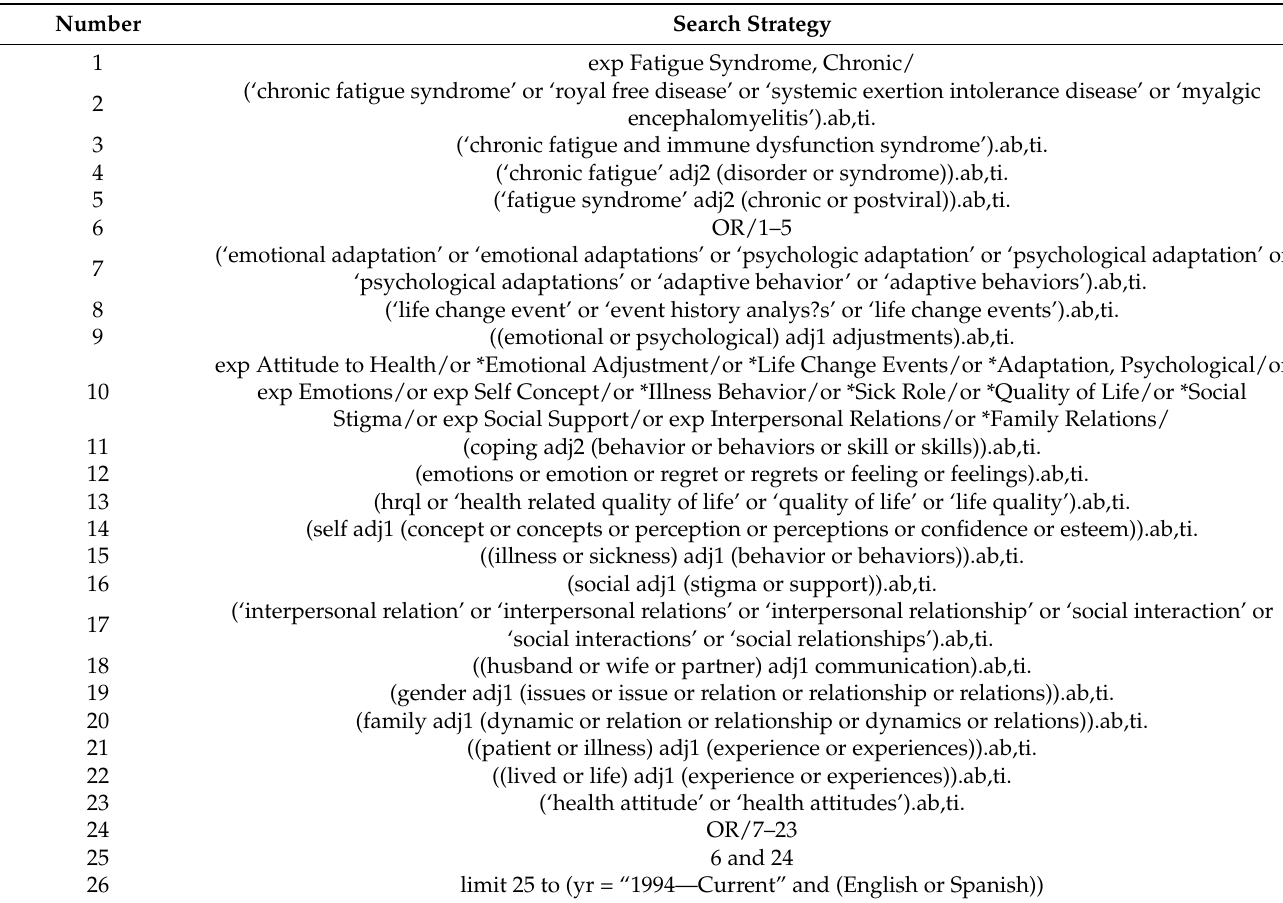
Table 1. The search strategy designed for the Medline and Medline In-Process databases using the Ovid SP